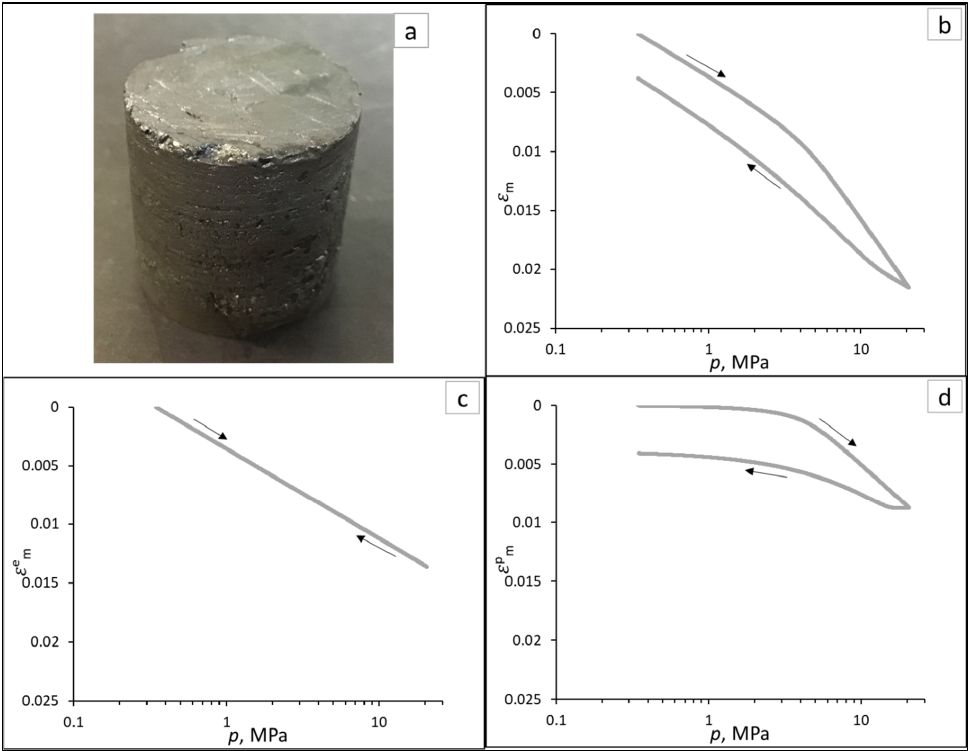
Figure 18. Photo and calculation of coal sample 1 (test 1).